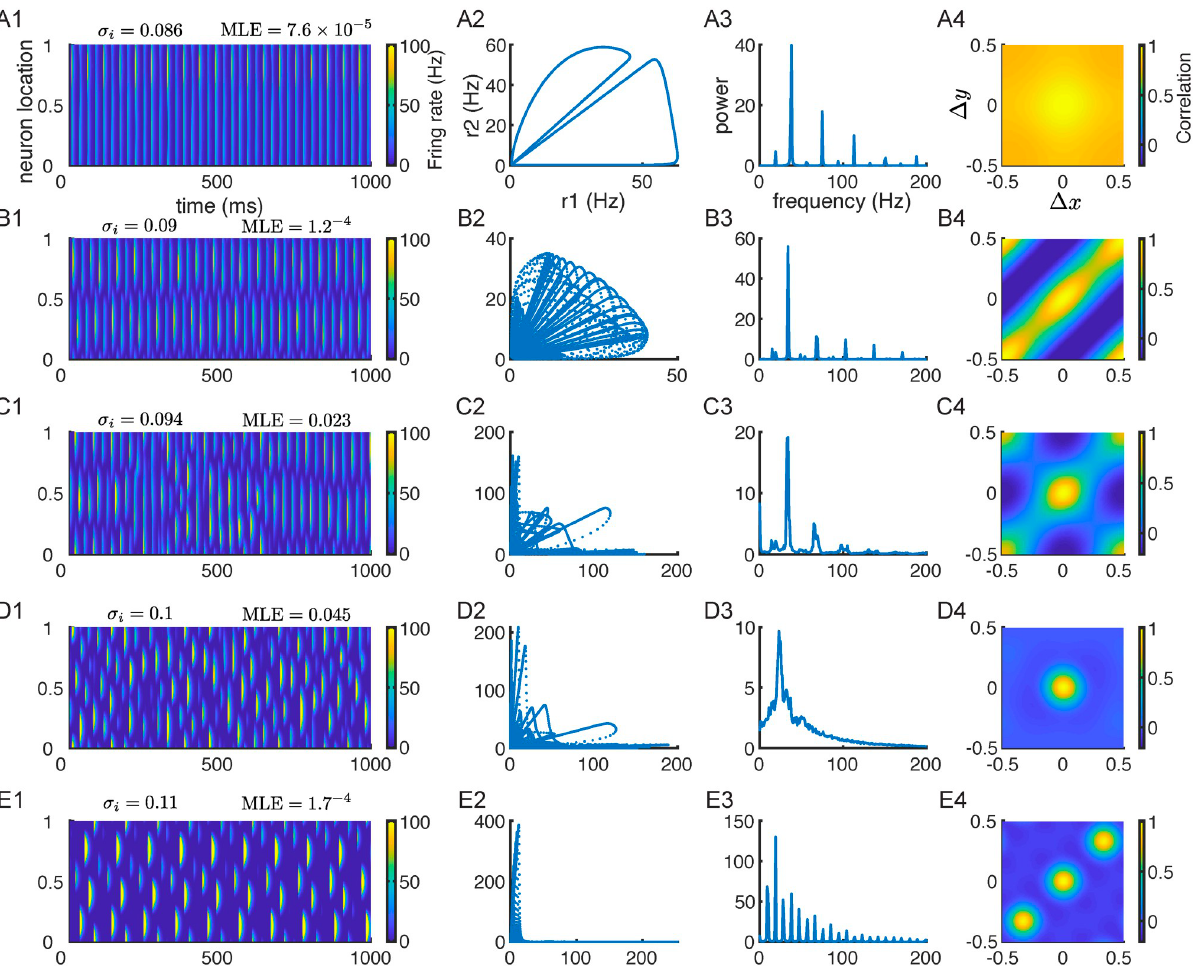
Fig 5. Transition to chaos as the inhibitory projection width ( σ ) increases. A1-E1 . Firing rate dynamics of excitatory neurons from a vertical slice of i the network. The MLE of the solution is shown on top. A2-E2 . Phase plots of firing rates of two excitatory neurons from different locations. A3-E3 . Population averaged power spectrum of single-neuron rate activity (Eq 12). A4-E4 . The correlation between neuron activity as a function of distance in x and y directions (Eq 11). The inhibitory time constant is fixed as τ i = 11 ms.